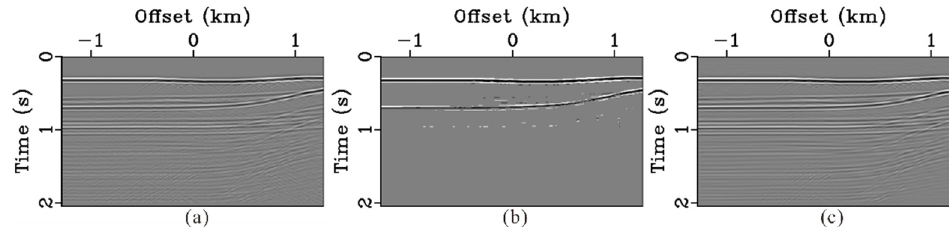
Figure 4. Sparsity comparison of the synthetic data. ( a ) Input data. ( b ) Sparse reconstruction in the time domain. ( c ) Sparse reconstruction in the curvelet domain.